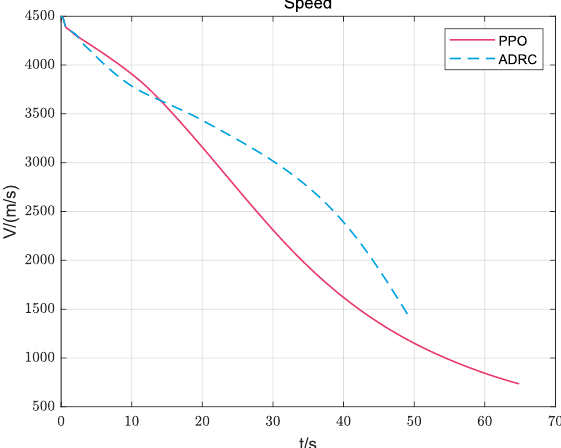
Figure 6. Speed curves when no fault occurs.